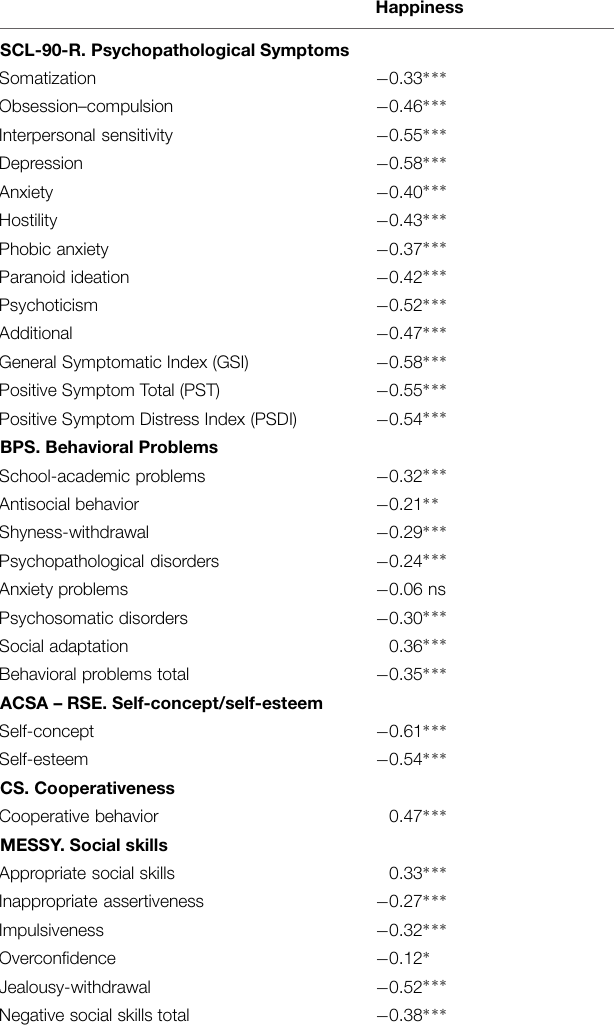
TABLE 2 | Pearson correlation coefficients between happiness and psychopathology, behavioral problems, self-concept, self-esteem, and social